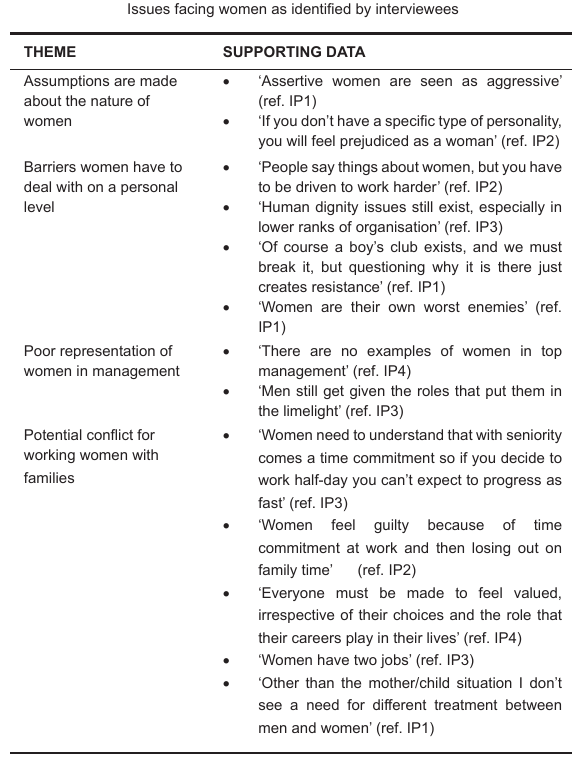
TABLE 9 Issues facing women as identified by